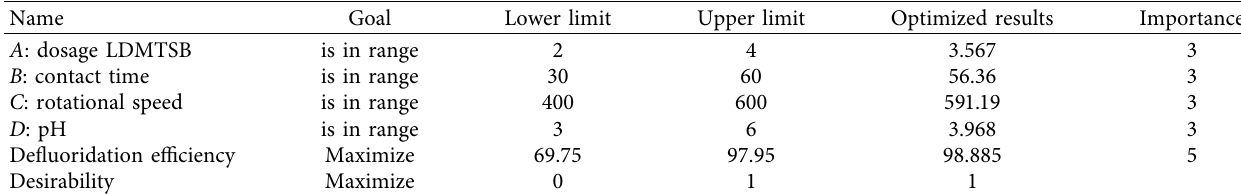
Table 7: Optimized results for the defluoridation